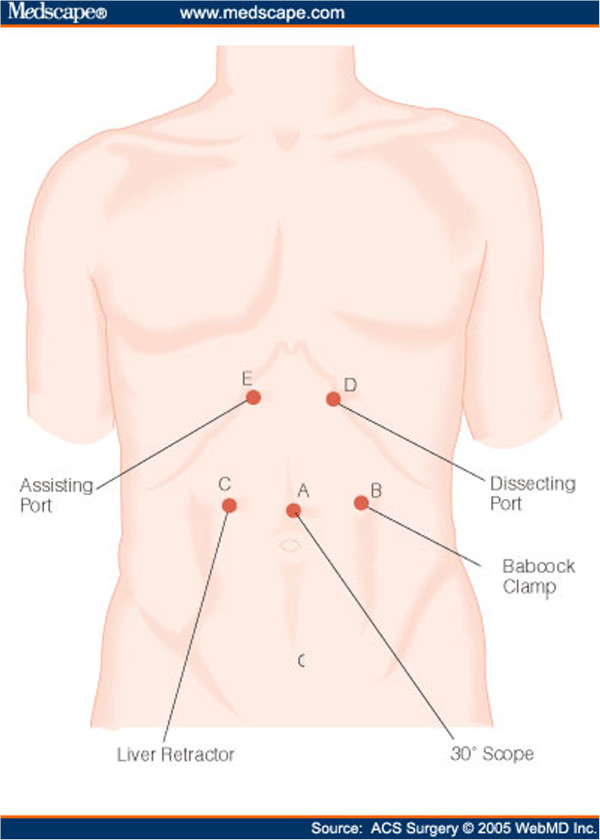
Trocar placement.